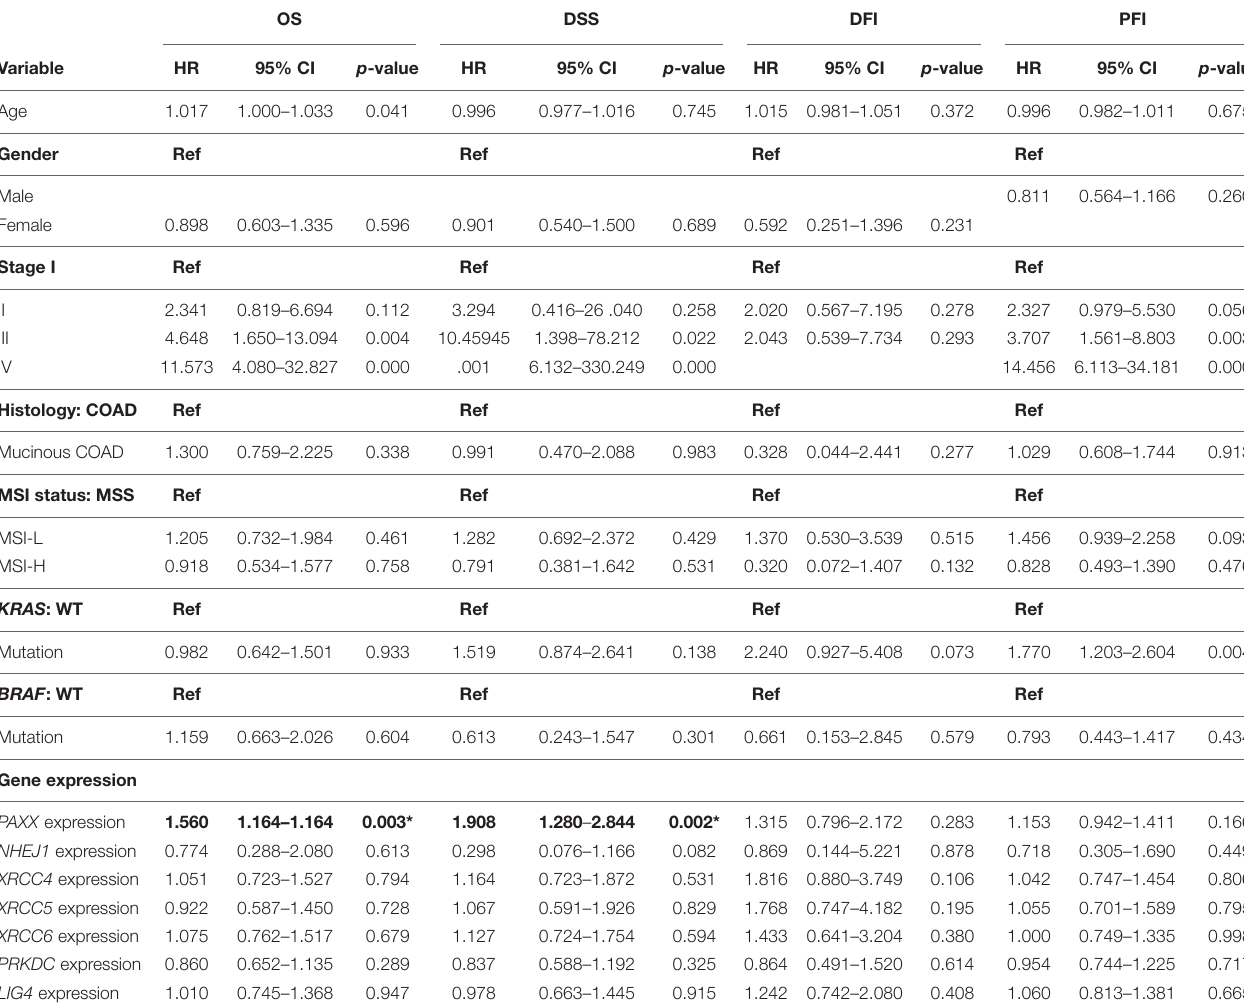
TABLE 2 | Univariate analysis of the NHEJ pathway genes and clinicopathological parameters in TCGA-COAD